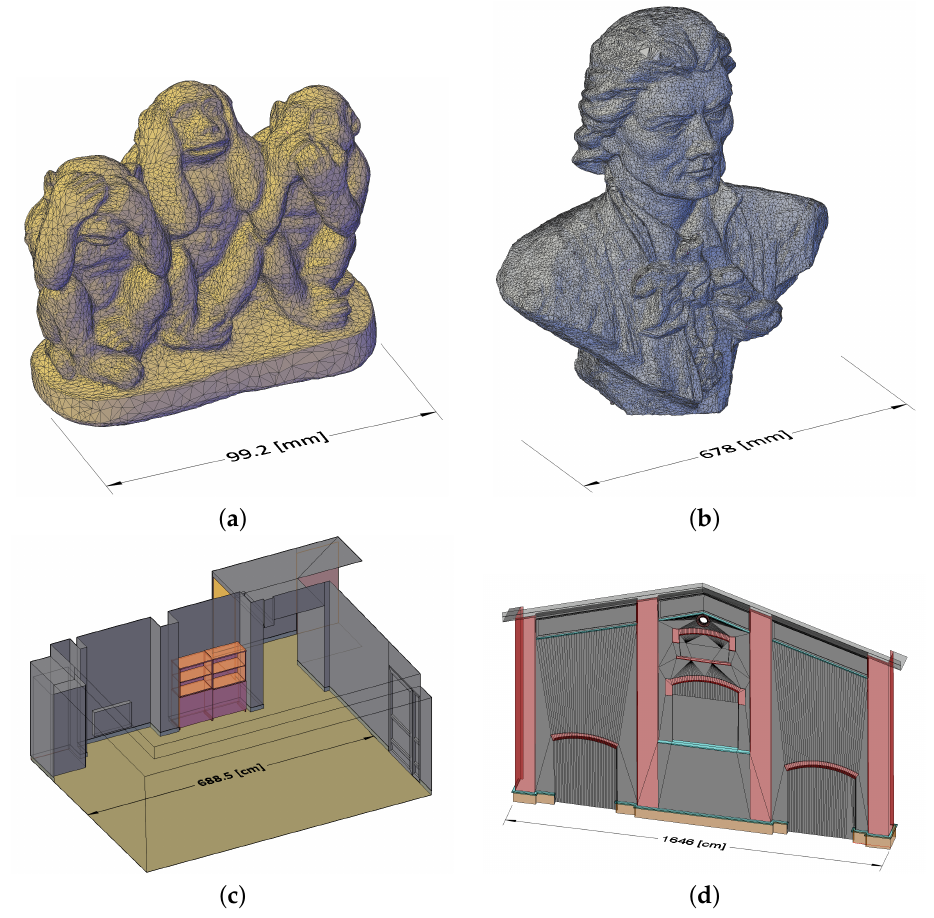
Figure 3. Reference models: ( a ) small figure model— Three Wise Monkeys, Konica-Minolta laser scanner; ( b ) medium model—bust of Tadeusz Ko´sciuszko, Creaform Academia 3D scanner; ( c ) interior model— student lounge, CAD model; ( d ) facade model—CUT cannon shed building, CAD